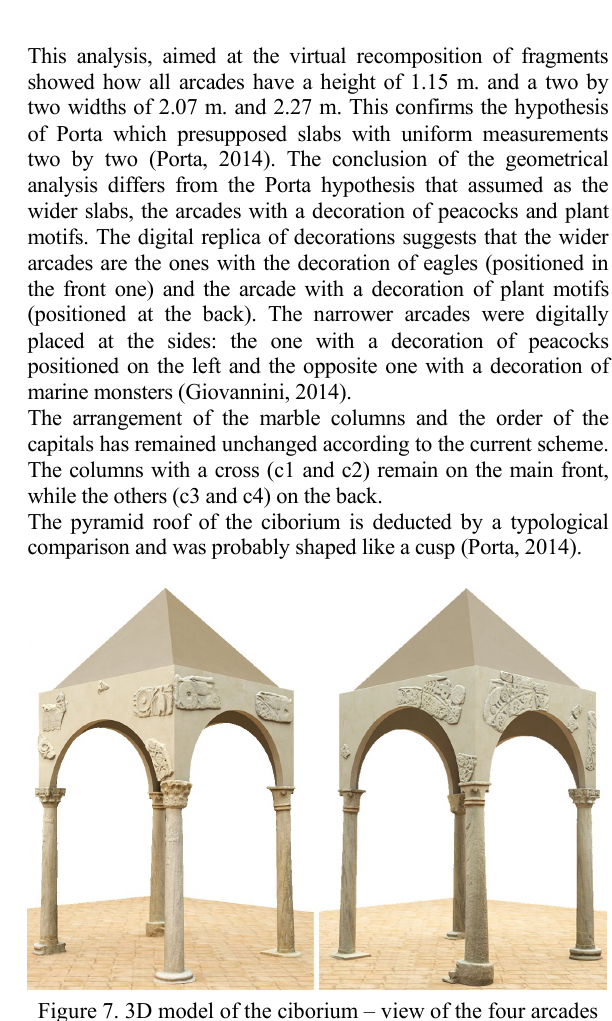
Figure 8. Uncertainty gradient colour code (Apollonio,